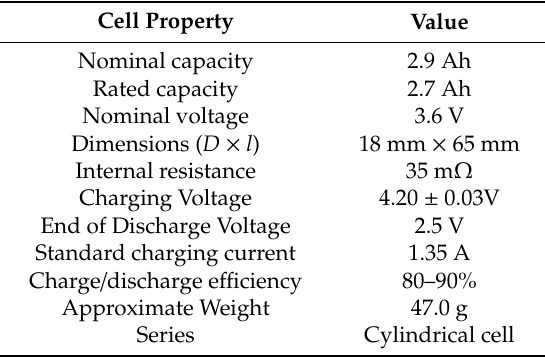
Figure 2. The equivalent circuit model (ECM) for lithium-ion battery.